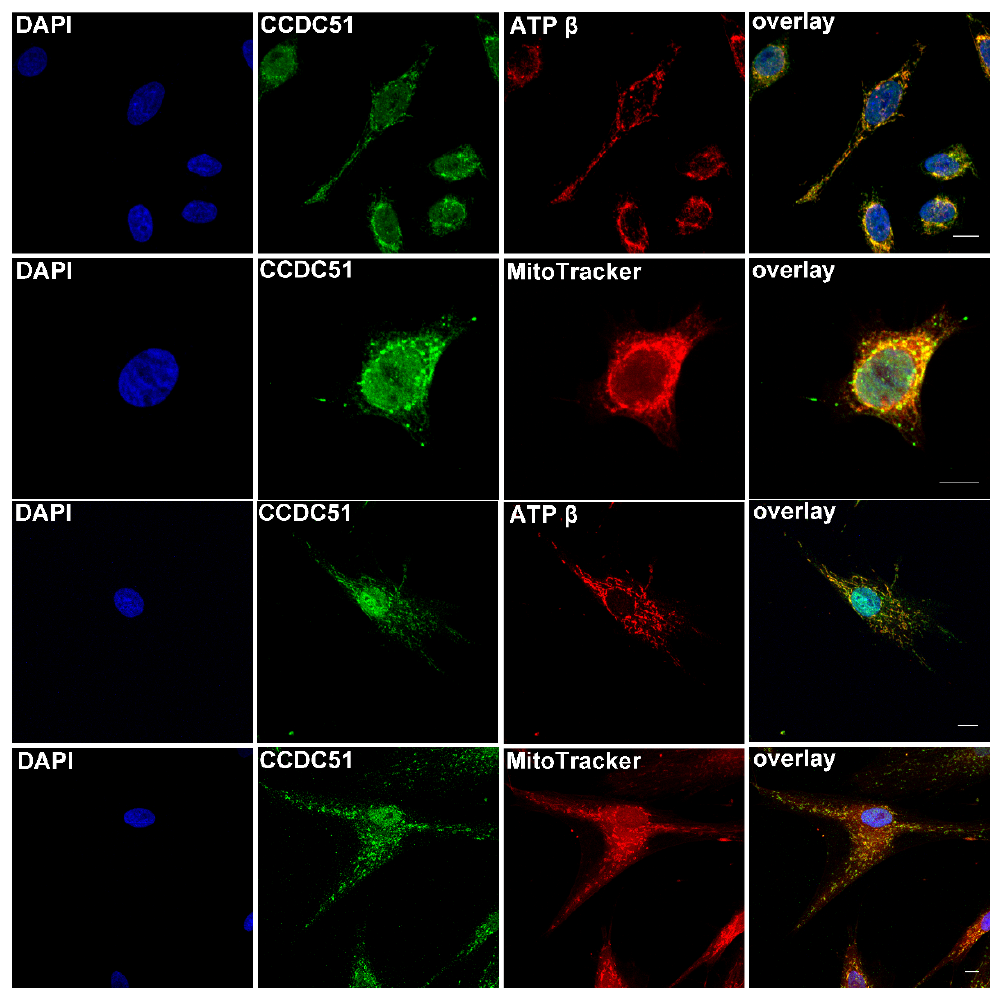
Figure 4. Detection of endogenous CCDC51/MITOK in human cell lines. Endogenous CCDC51/MITOK was detected with the rabbit anti-CCDC51 antibody in HeLa cells (upper two rows) and fibroblast cells (lower two rows) (green and yellow). A similar staining was obtained with the mitochondrial mouse anti-ATP synthase subunit beta antibody and a MitoTracker (red and yellow). Nuclei were stained with DAPI (blue) (bar = 20 μ m).